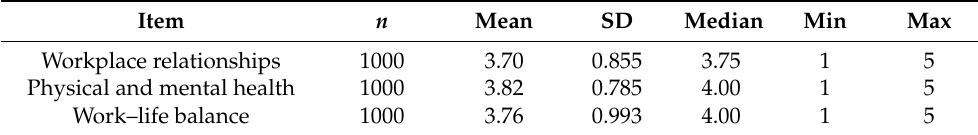
Table 3. Descriptive statistics of employee well-being